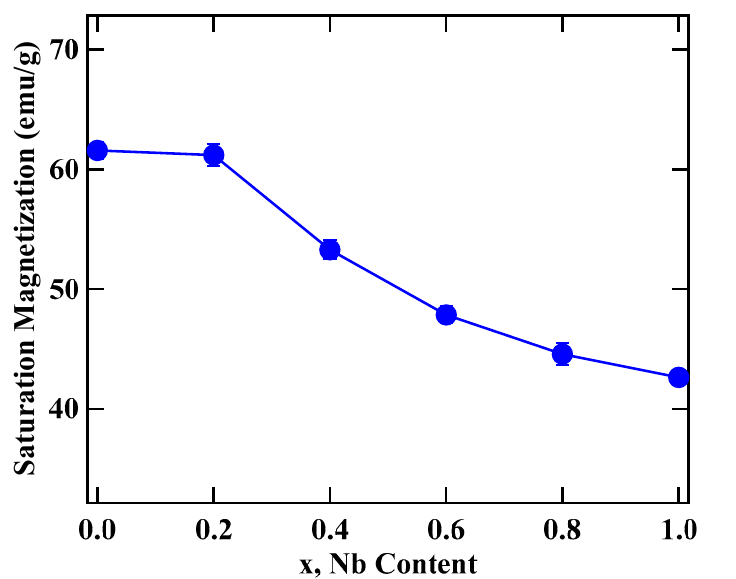
Figure 3. RT magnetization plot for Dy 2 Fe 16 Ga 1 − x Nb x .